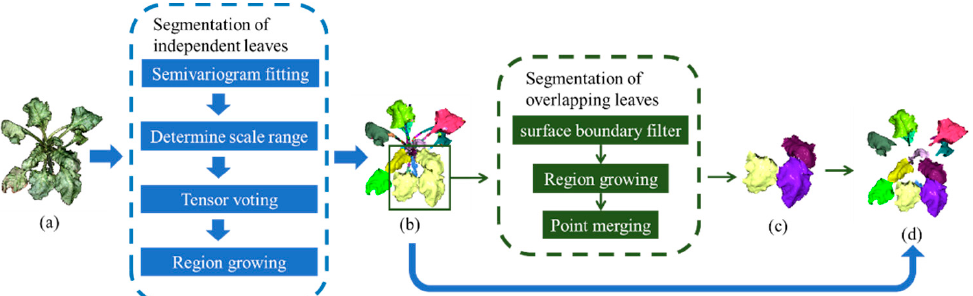
Figure 2. Steps for processing point cloud of individual sugar beet leaves: ( a ) point cloud of individual sugar beet plant needs to be segmented; ( b ) point cloud of overlapping leaves needs to be segmented; ( c ) separated individual leaves by further segmentation of the point clouds for overlapping leaves; ( d ) final segmentation of individual leaves, different leaves were represented with different colors.